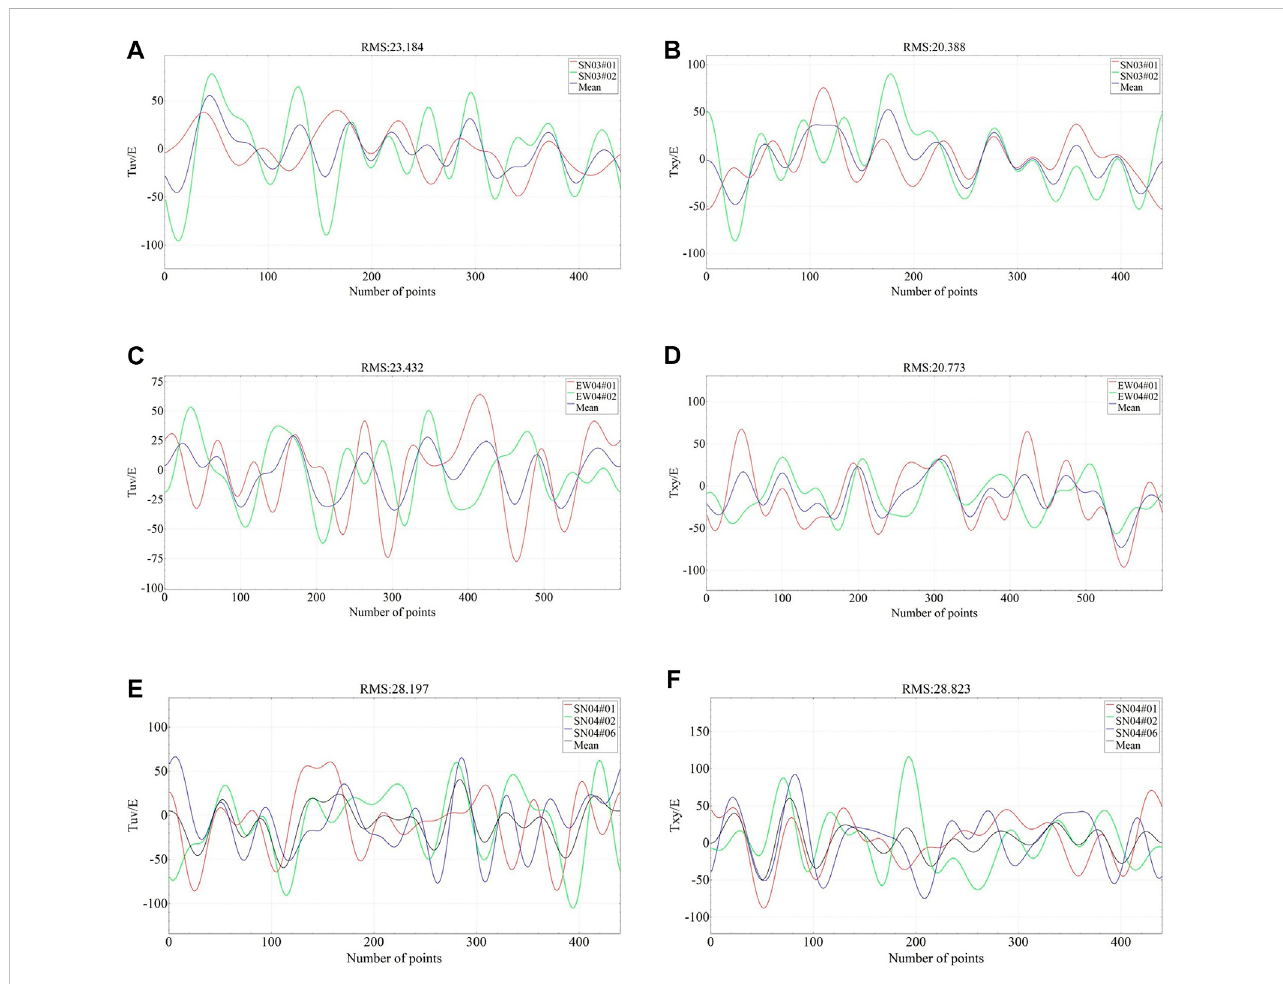
FIGURE 11 (A – F) T uv and T xy component of Repeat line internal accord accuracy